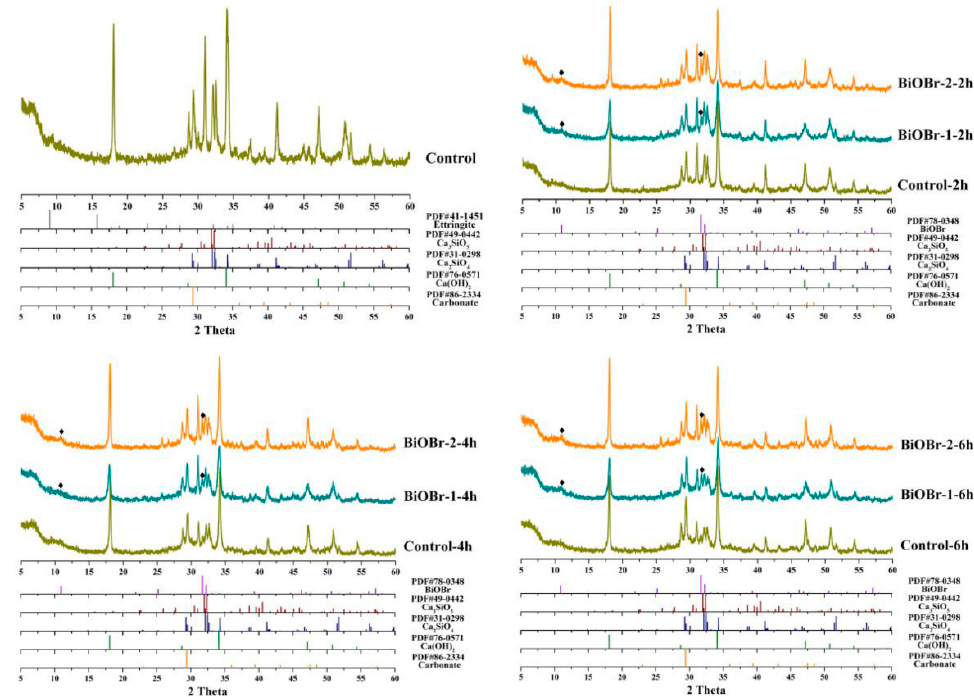
Figure 4. XRD patterns of different samples with different curing conditions.